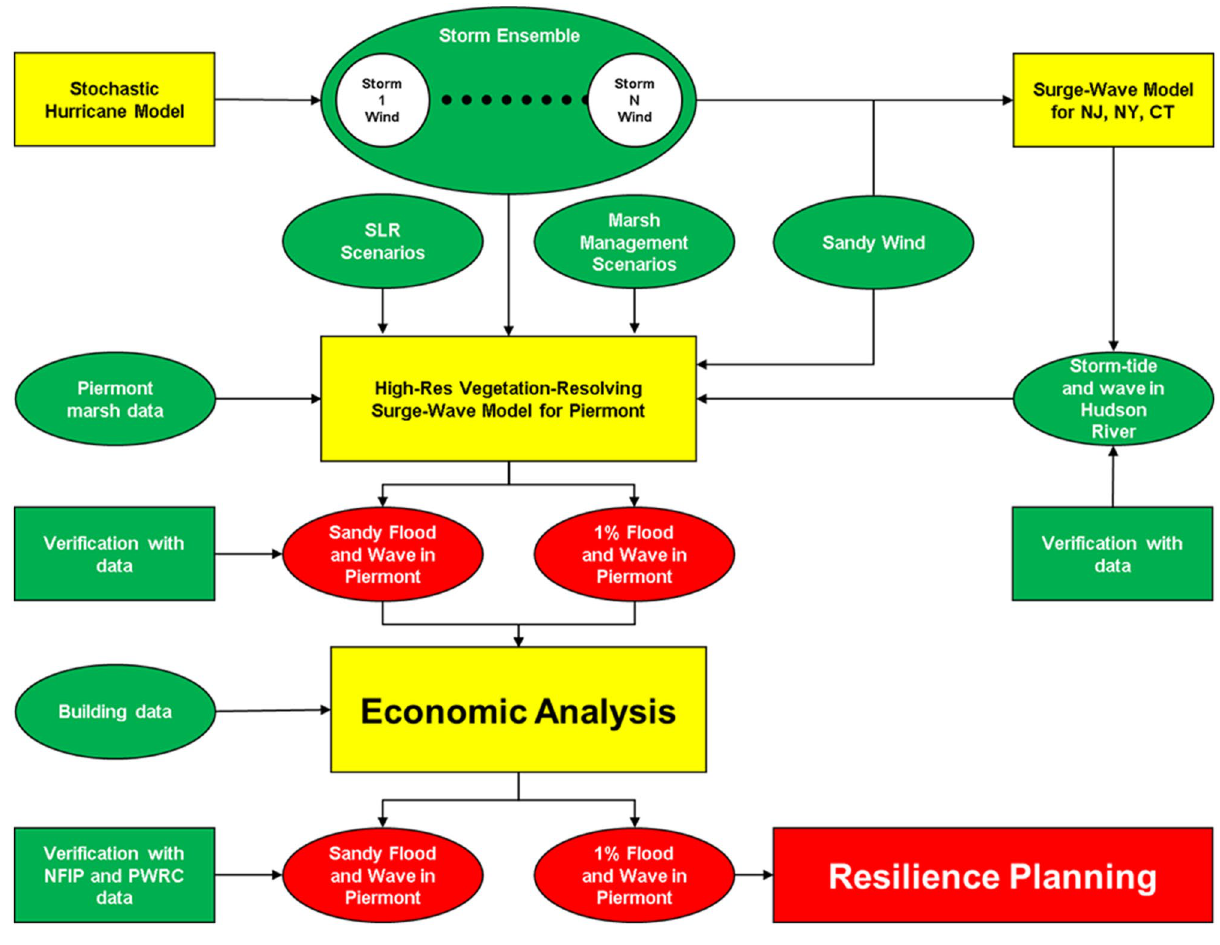
Figure 7. Schematics of the overall